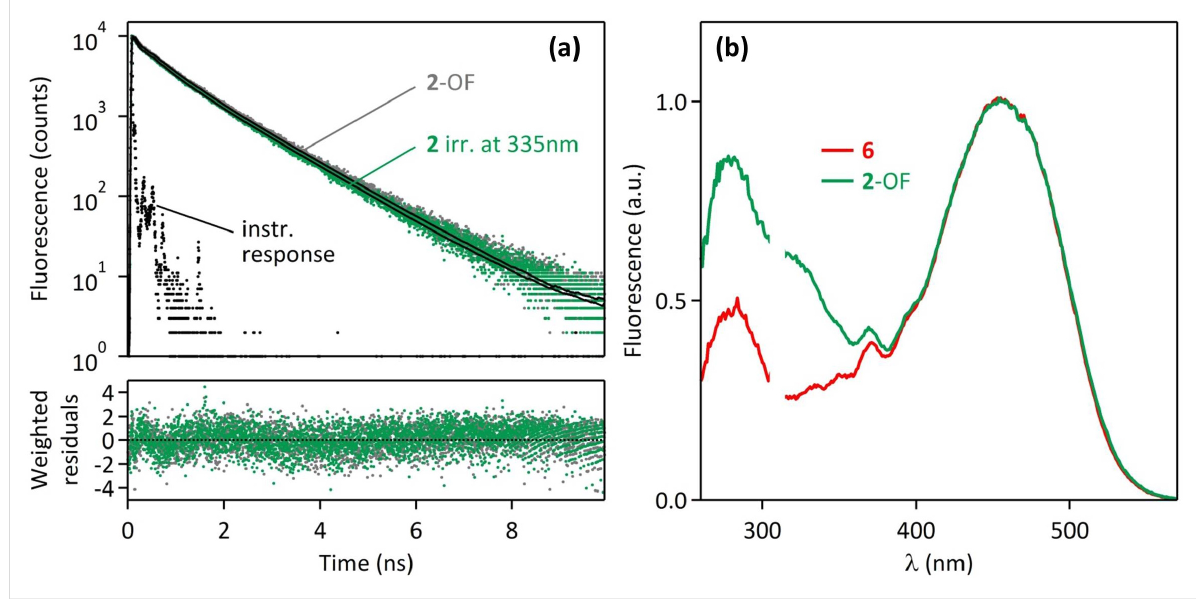
Figure 6: (a) Fluorescence decays ( λ exc = 475 nm, λ em = 610 nm) of compound 2 -OF, and 2 after irradiation at 335 nm in CH 3 CN (7 mW cm − 2 ). (b) Normalized excitation spectra ( λ em = 620 nm) of 6 (red line) and 2 -OF (green line) in CH 3 CN.